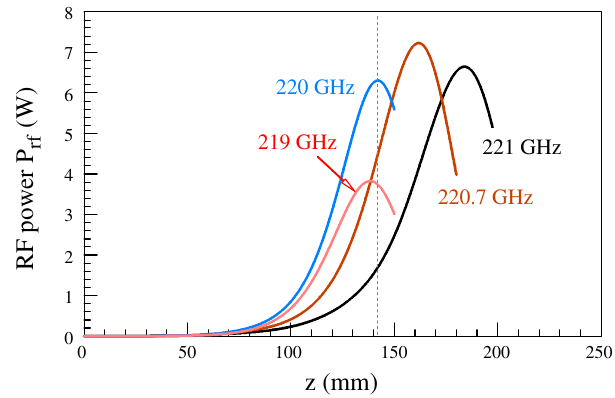
FIG. 10. (Color) (Given beam energy). The rf power profiles for different rf frequencies for a 30.20-keV beam. It is seen that the frequency bandwidth is about 2 GHz (0.9%) at FWHM for a 142- mm interaction